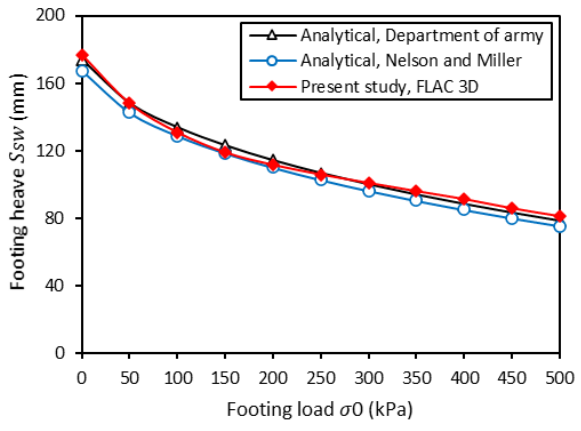
for square footing sw